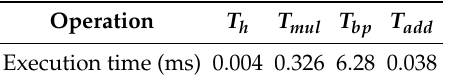
Table 4. The execution time of basic operation.